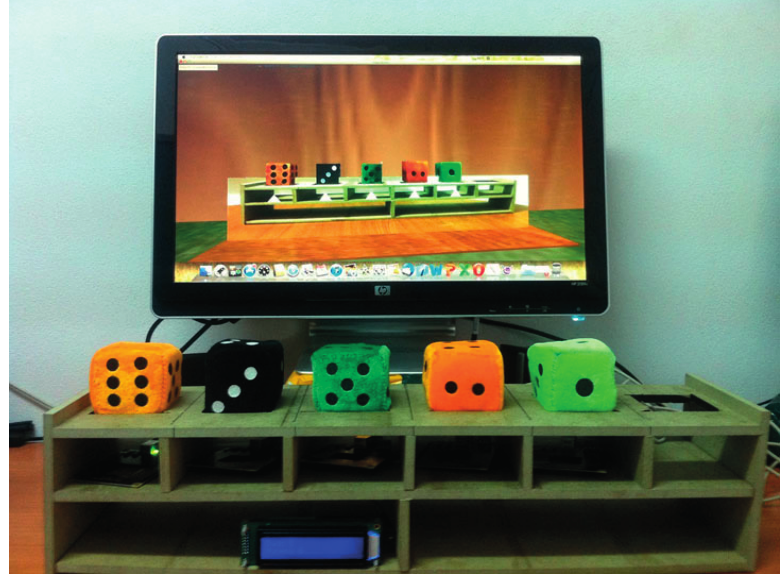
Figure 7. The Cubica educational